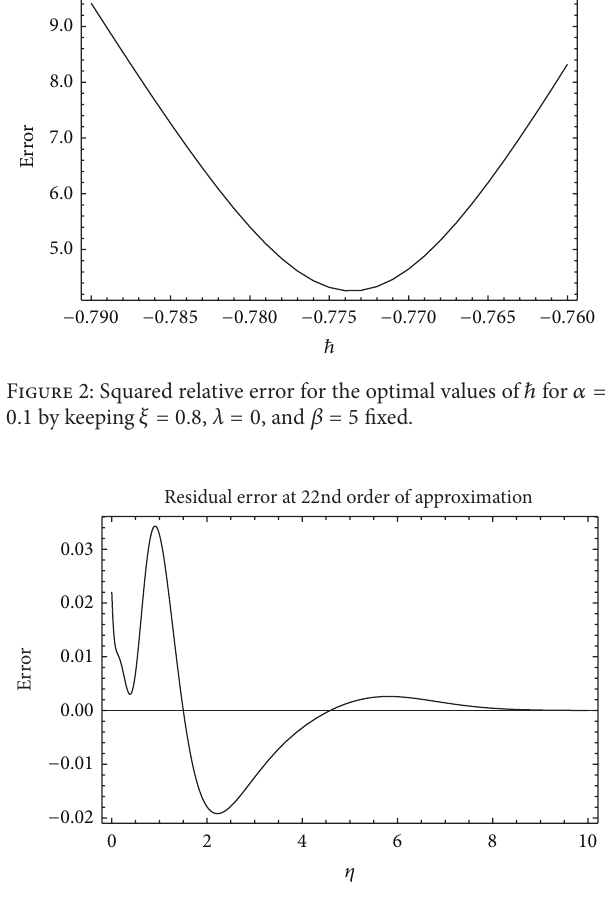
Figure 3: The residual error of the 22 nd order of HAM solution in case of 𝛼 = 0.2 , 𝜉 = 0.8 , 𝜆 = 0 , 𝛽 = 5 , and ℎ = −0.6815 . Table 1: Convergence of HAM solution for different orders of pad´e approximation of 𝑓 󸀠󸀠 (0,𝜉) , when 𝜉 = 0.8 , 𝛼 = 0.2 , 𝛽 = 5 and 𝜆 = 0 . Order of approximation